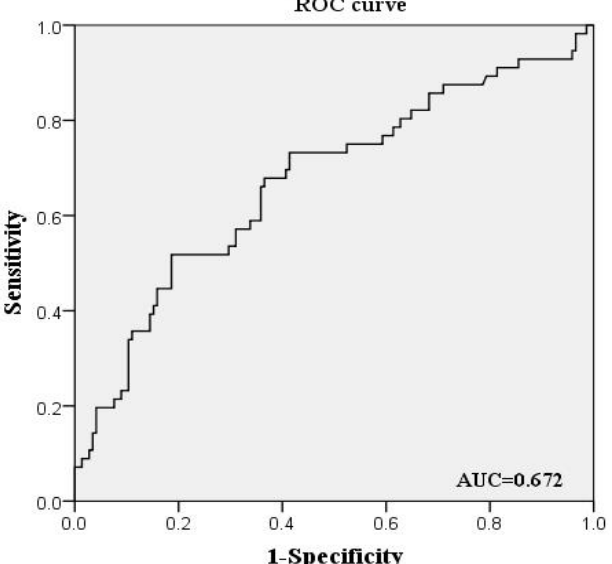
Figure 2. The ROC curve for the prediction of a right ‐ to ‐ left shunt in the near ‐ cortical white matter lesions. Table 4. Comparison of white matter lesions between the RLS ‐ positive group and the RLS ‐ negative group.